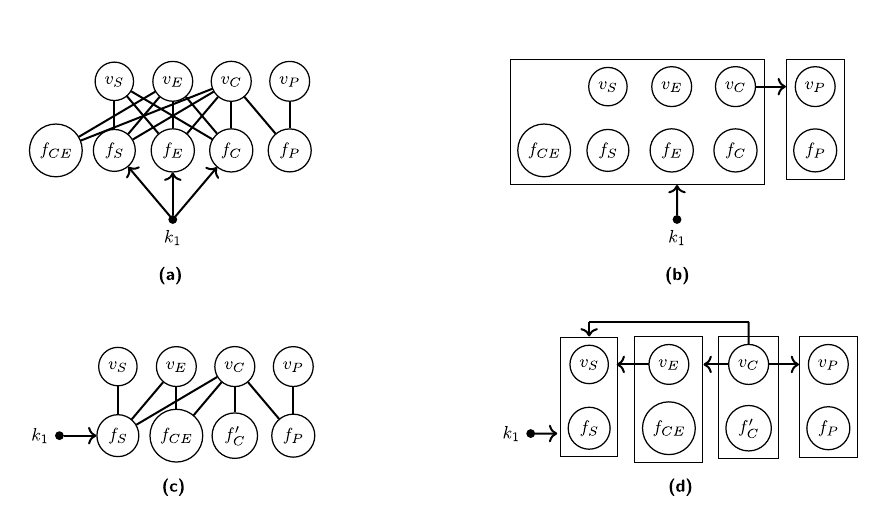
Figure A2: Di ff erent graphical representations of the basic enzyme reaction at equilibrium. Panels ( a ) and ( b ) show the equilibrium bipartite graph and equilibrium causal ordering graph, respectively, for the equilibrium equations ( A5 ) , ( A6 ) , ( A7 ) , ( A8 ) , and ( A9 ) . Panels ( c ) and ( d ) show the equilibrium bipartite graph and the equilibrium causal ordering graph, respectively, for the rewritten equilibrium equations ( A5 ) , ( A8 ) , ( A9 ) , and ( A10 ) . Rewriting the equilibrium equations yields a sparser equilibrium bipartite graph, and therefore, more structure is revealed in the equilibrium causal ordering graph.